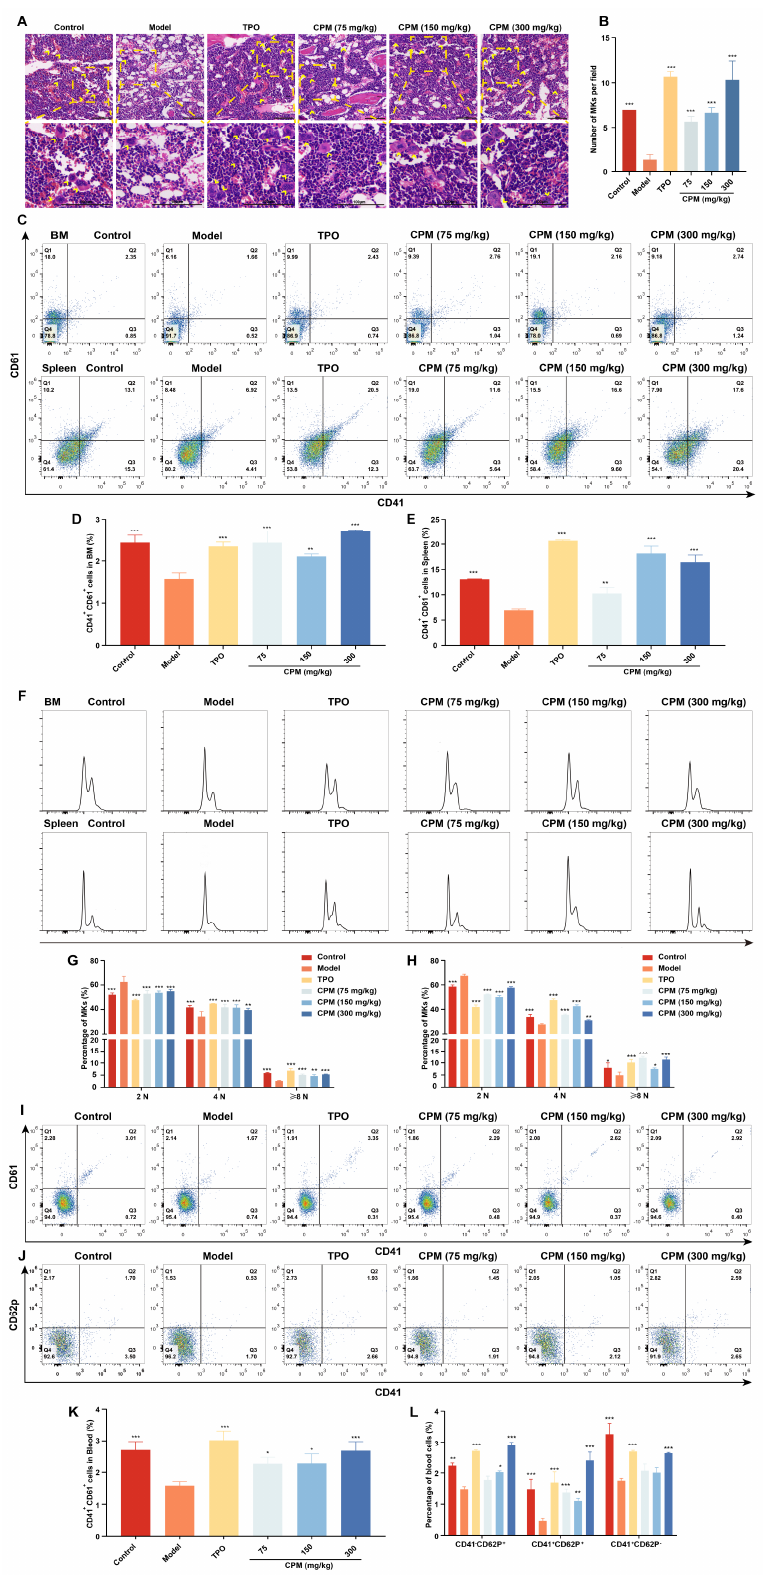
Figure 4. CPM promotes MK differentiation, maturation and platelet activation in RIT mice. ( A ) H&E staining of BM in control, model, TPO and CPM-treated groups on day 10. Bars: 100 µ m. The MKs are indicated by arrows. ( B ) The MK counts of each group in BM. Data are mean ± SD (n = 3). ( C )